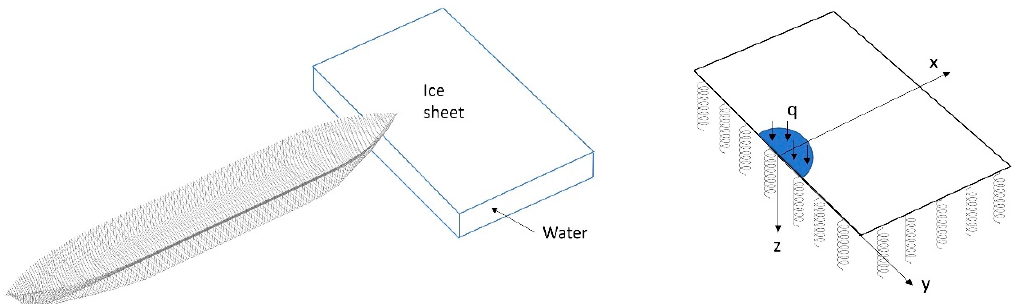
Figure 11. The ice bending model illustration: a semi-infinite plate resting on an elastic foundation and subjected to a uniform distributed load.